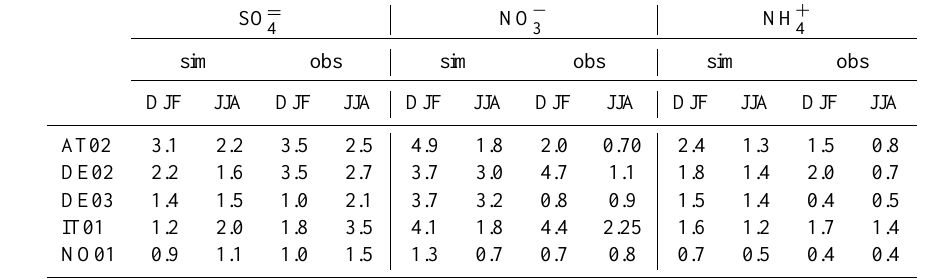
precipitation are between − 0.2 and − 0.35 at lag = 0 or